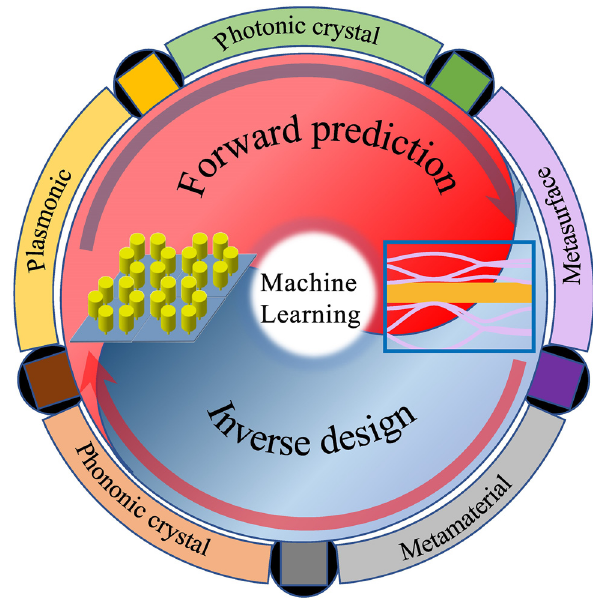
Figure 1: Diagrammatic sketch of machine learning for properties characterization and structural design of artificial materials. The machine learning algorithms are applied to connect the structure (such as phononic crystal, metamaterial, metasurface, photonic crystal and plasmonic) information with the response information (for example, band gap, transmission